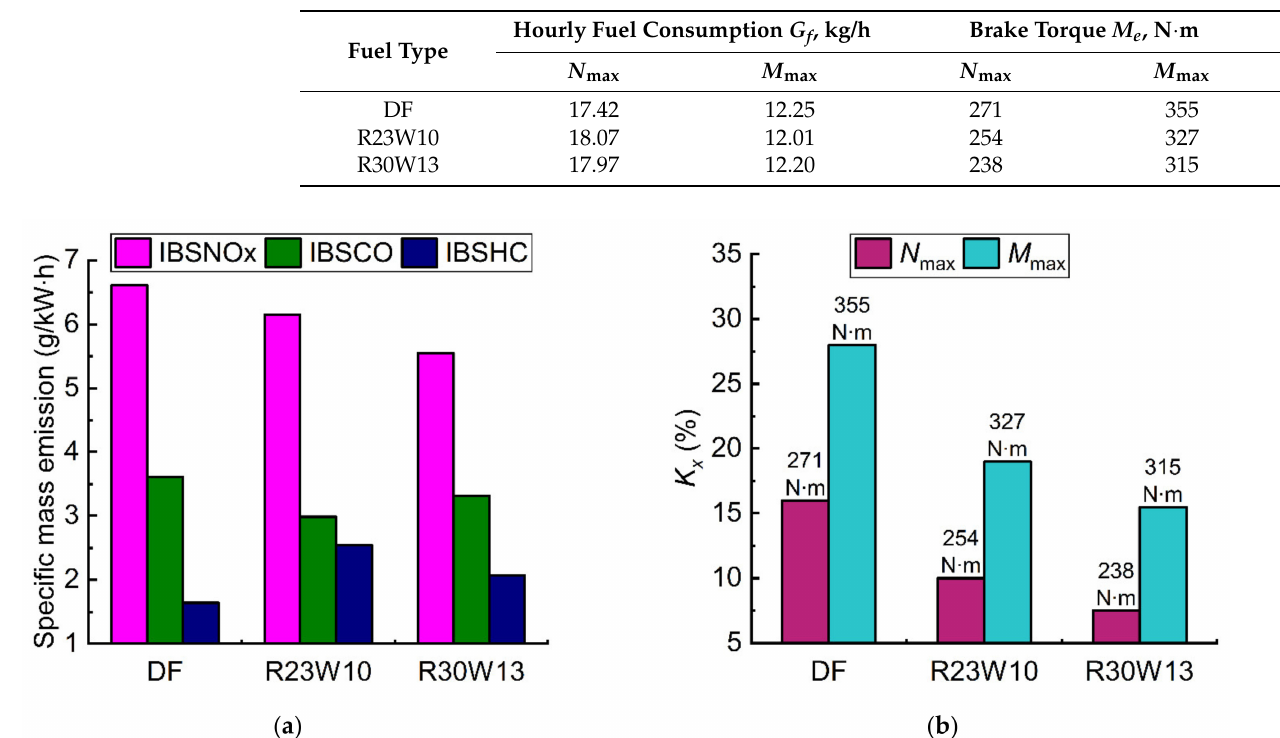
Table 7. Hourly fuel consumption and engine brake torque for DF and emulsified multicomponent biofuels in the maximum power ( N max ) and maximum torque ( M max ) modes.